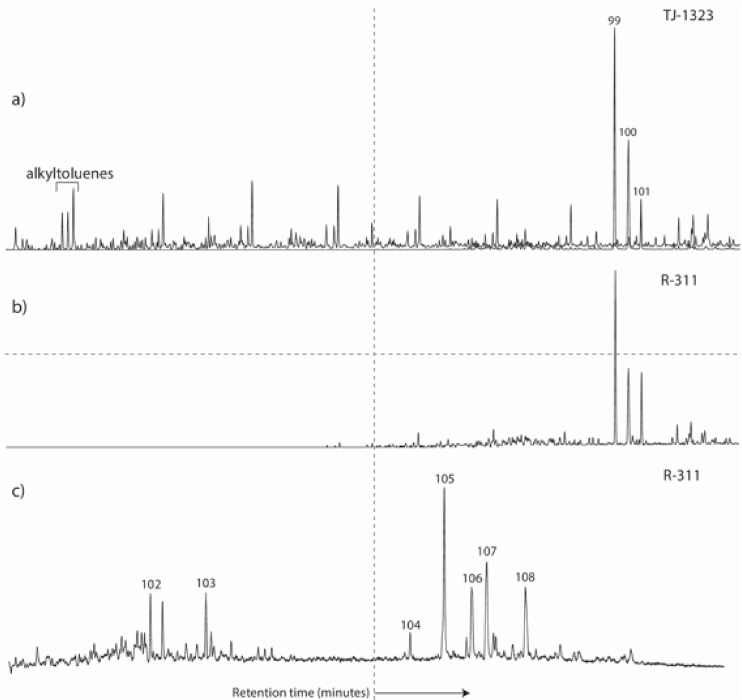
Figure 8. The m / z 105 + 198 ion chromatograms of the aromatic fraction for TJ-1323 ( a ) and R-311 ( b ) oils showing methyldibenzothiophene and alkyltoluene distributions; ( c ) representative m / z 231 ion fragmentogram of the aromatic fraction of the R-311 oil showing the triaromatic steroidal hydrocarbon